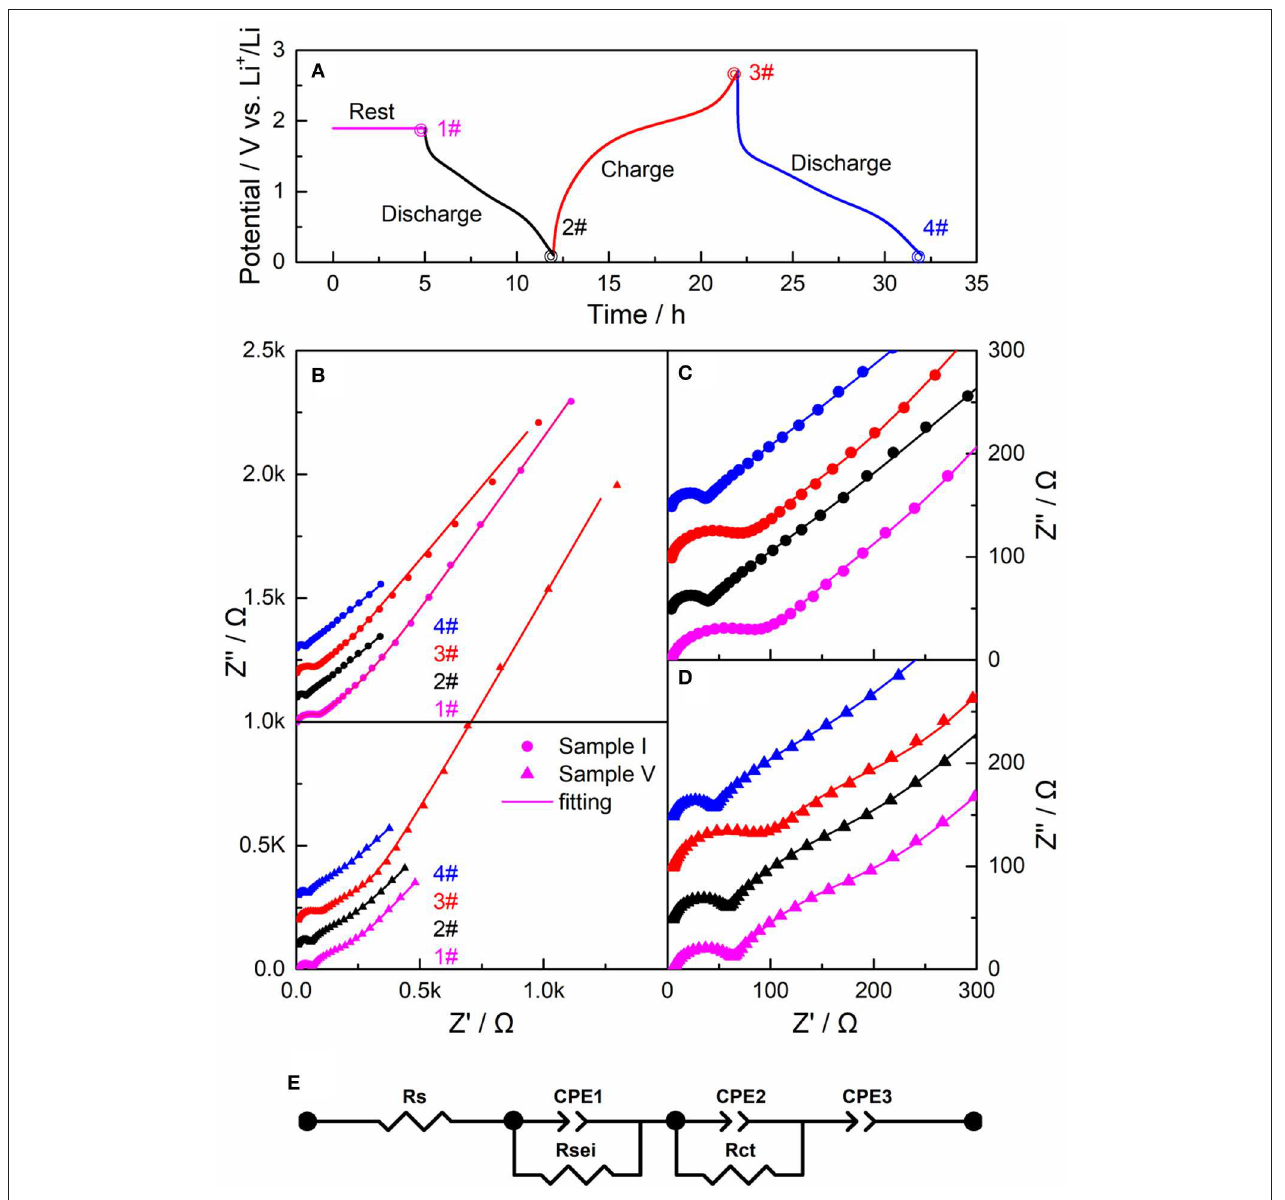
FIGURE 7 | (A) The electrochemical measurements after 10 cycles as rest for 5h (1#), discharge to 0.1V (2#), charge to 2.7V (3#), and discharge to 0.1V (4#) with a current of 0.05C. (B) The impedance spectra of Sample I. Pristine LiBC and Sample V. 600-powder-Al at State 1# (magenta), State 2# (black), State 3# (red), and State 4# (blue), and the corresponding enlarged views in (C,D) . (E) The equivalent circuit to fit the impedance spectra in (B–D) as the curve